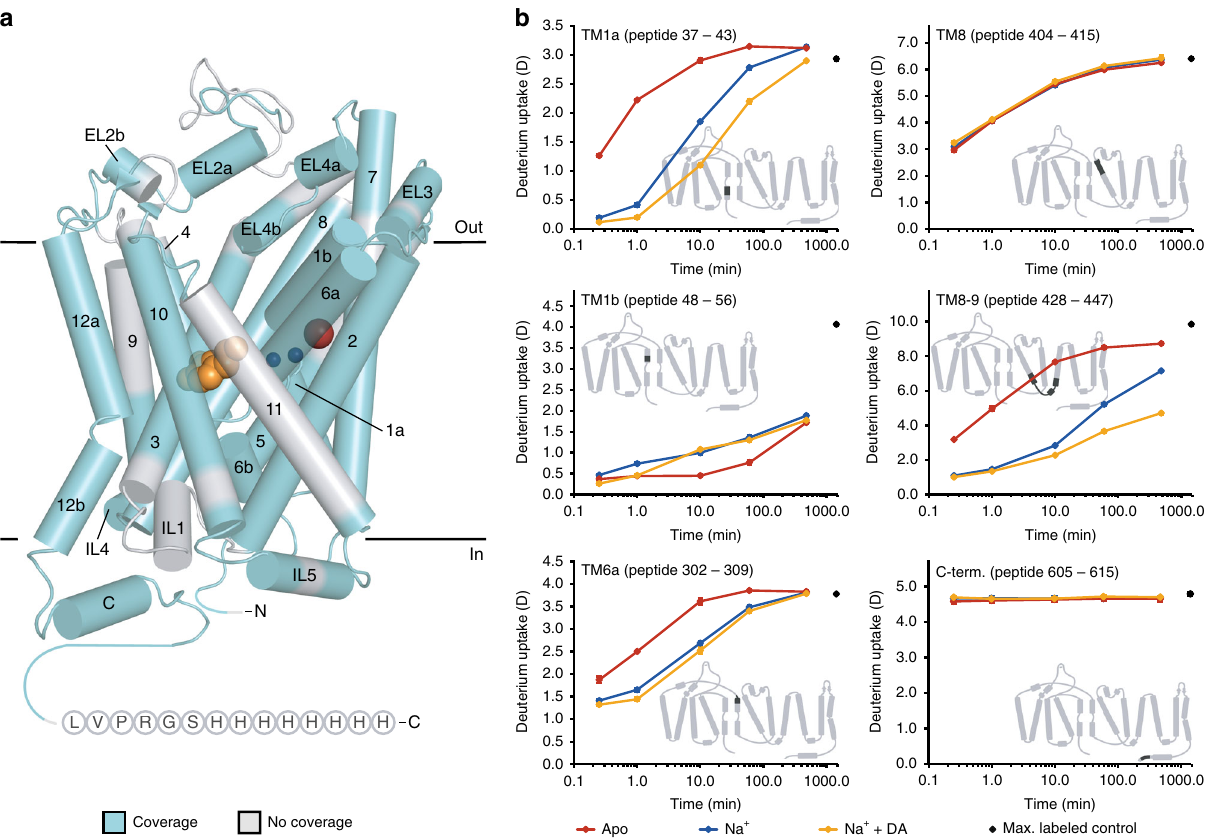
Fig. 2 HDX of local regions of dDAT in different functional states. a Cylindrical representation of the crystal structure of dDAT in complex with two Na + ions (blue spheres), one Cl − ion (red sphere) and DA (orange spheres) (PDB ID: 4XP1). To obtain information about HDX of local regions of dDAT, we digested the transporter enzymatically and identi fi ed the generated peptides using MS. Regions of dDAT covered by identi fi ed peptides are highlighted in cyan. Wild-type dDAT was used for the HDX-MS experiments, however, the crystal structure shown has truncated N- and C-termini and deleted part of EL2. The C-terminal His-tag used for puri fi cation of the wild-type dDAT is added to the structure as circles with one-letter codes. b Deuterium uptake is plotted as a function of labeling time (i.e., 0.25 – 480 min) for representative peptides of dDAT. Red, blue, and orange curves illustrate the deuterium uptake for dDAT in the apo, Na + -bound, and Na + + DA-bound state, respectively. Values represent means of three (apo and Na + + DA) or six (Na + ) independent measurements. Standard deviations are plotted as error bars but are in most instances too small to be visible. Maximum-labeled control samples are shown as black circles at 1440 min. Insets: The location of the corresponding peptide is highlighted in black on the topology map of dDAT. Source data are provided as a Source Data fi